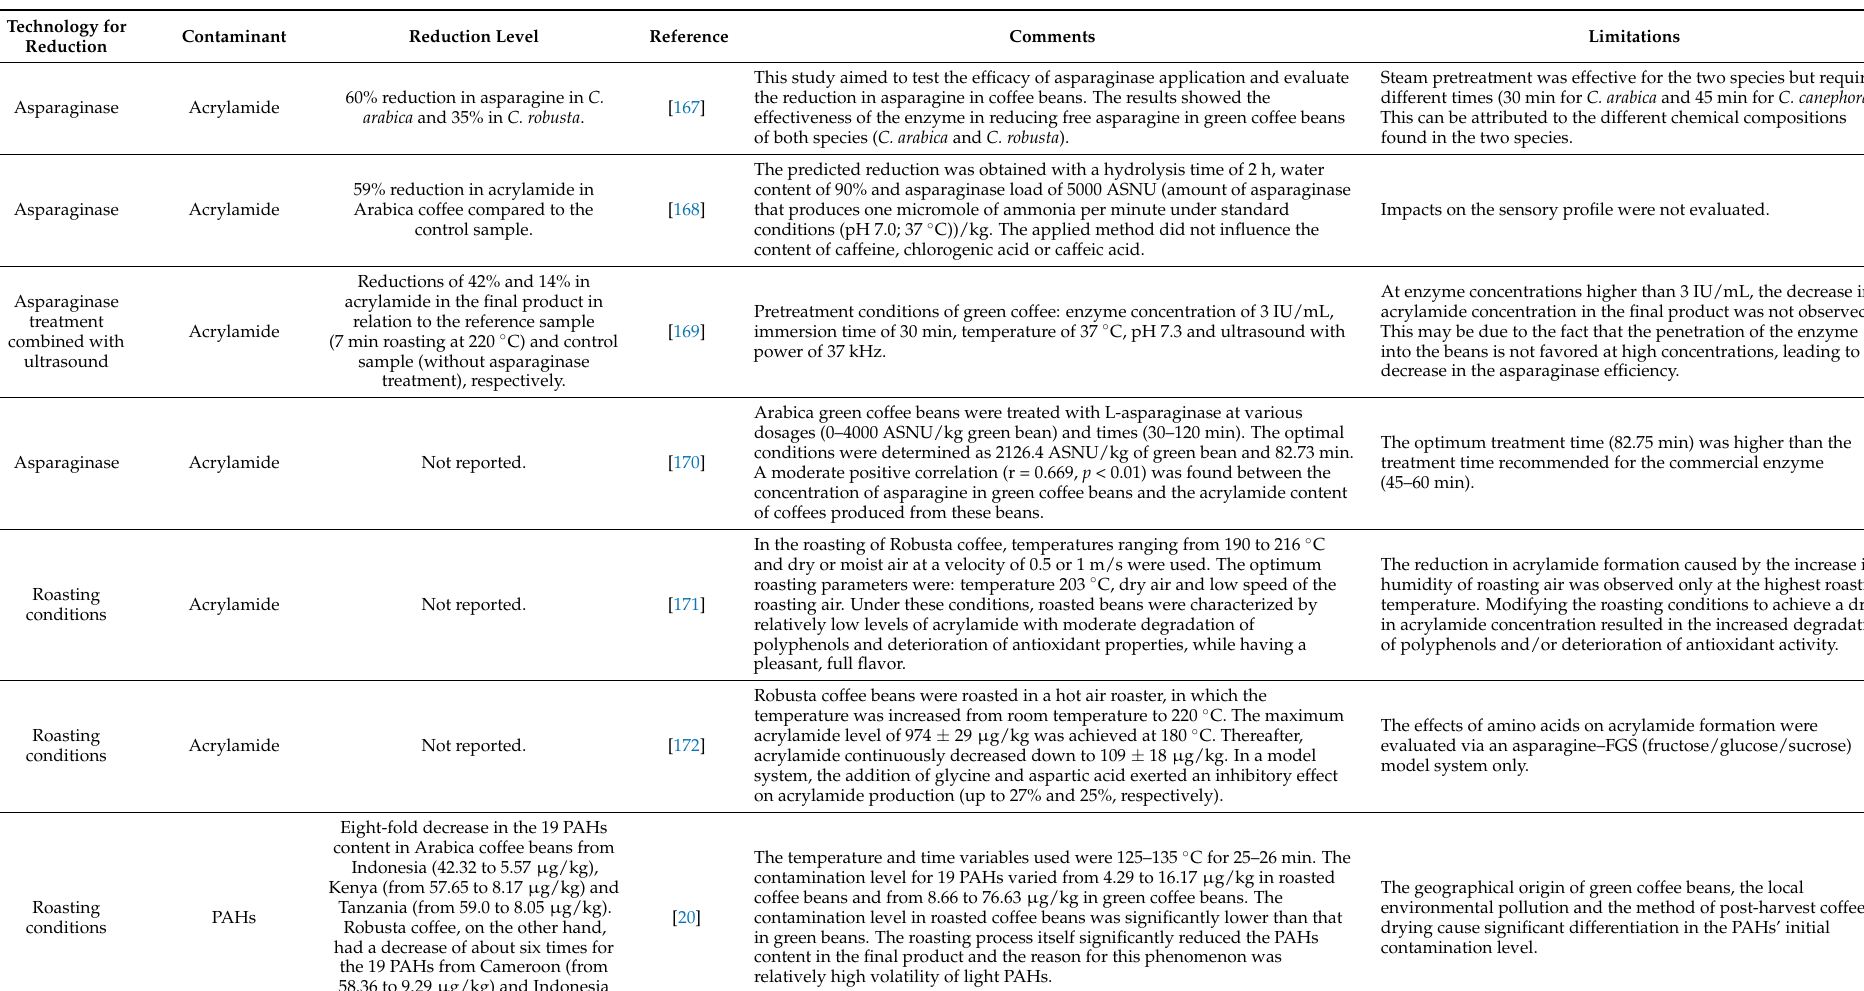
Table 2. Mitigation strategies for thermal contaminants in coffee induced by